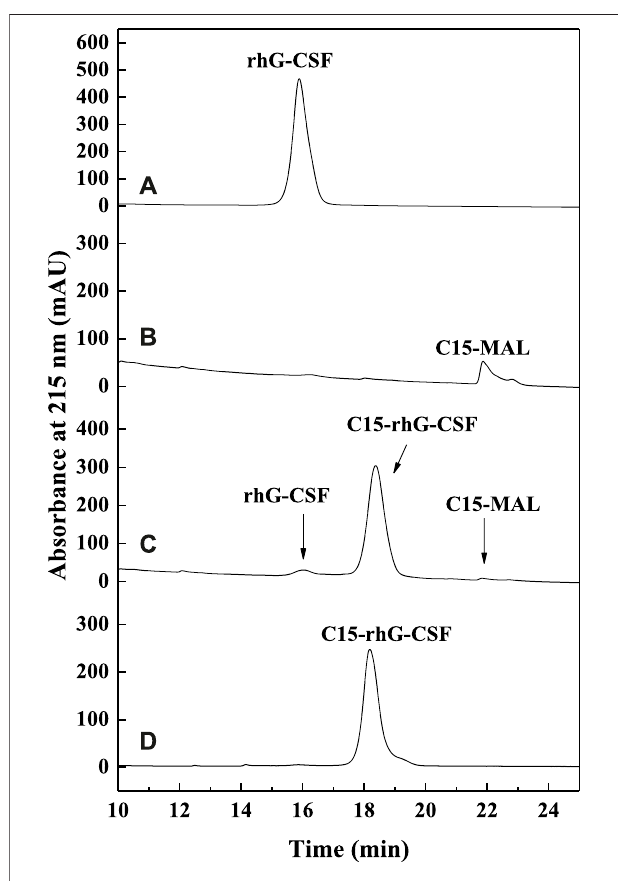
FIGURE 2 | The RP-HPLC analysis of the reaction mixture of the modi fi cation of rhG-CSF with C15-MAL. (A) rhG-CSF; (B) C15-MAL; (C) Reaction mixture; (D) Puri fi ed C15-rhG-CSF. Reaction conditions: rhG-CSF (1 mg/ml) and C15-MAL (mole ratio of C15-MAL to rhG-CSF 5:1) were reacted in 10:1 (v/v) DMSO-phosphate buffer (pH 7.0) at 20 ° C for 30